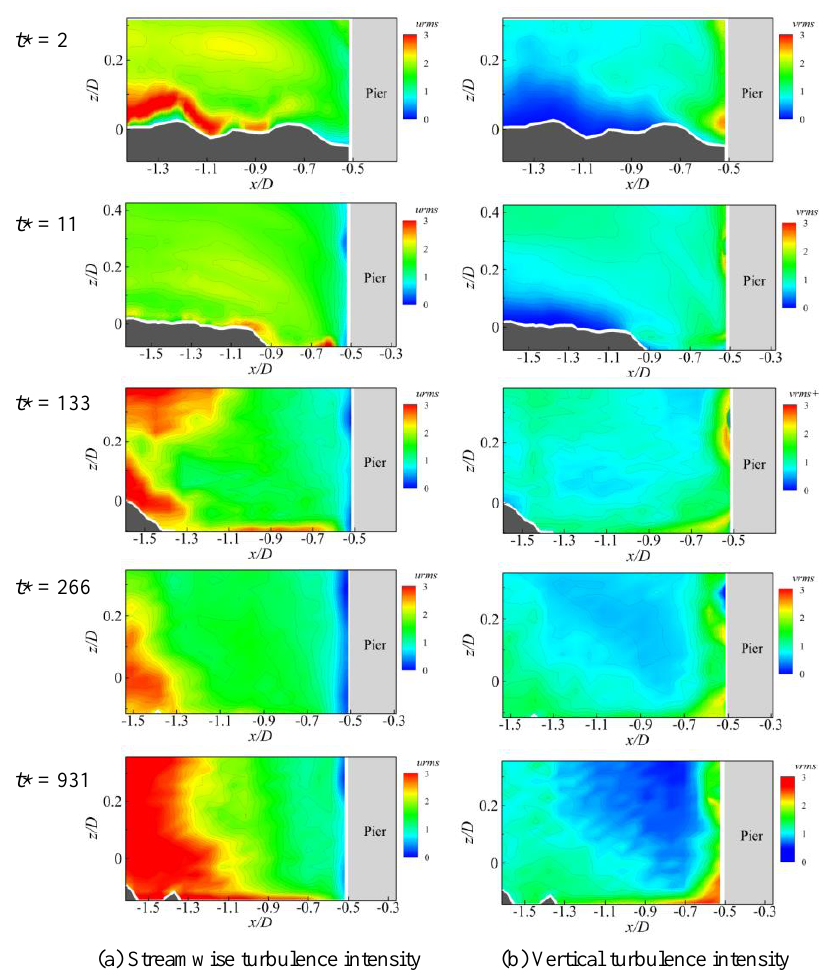
Figure 11. Contours of turbulence intensities at different time in the pier scouring process. ( a ) streamwise turbulence intensity, ( b ) vertical turbulence intensity.